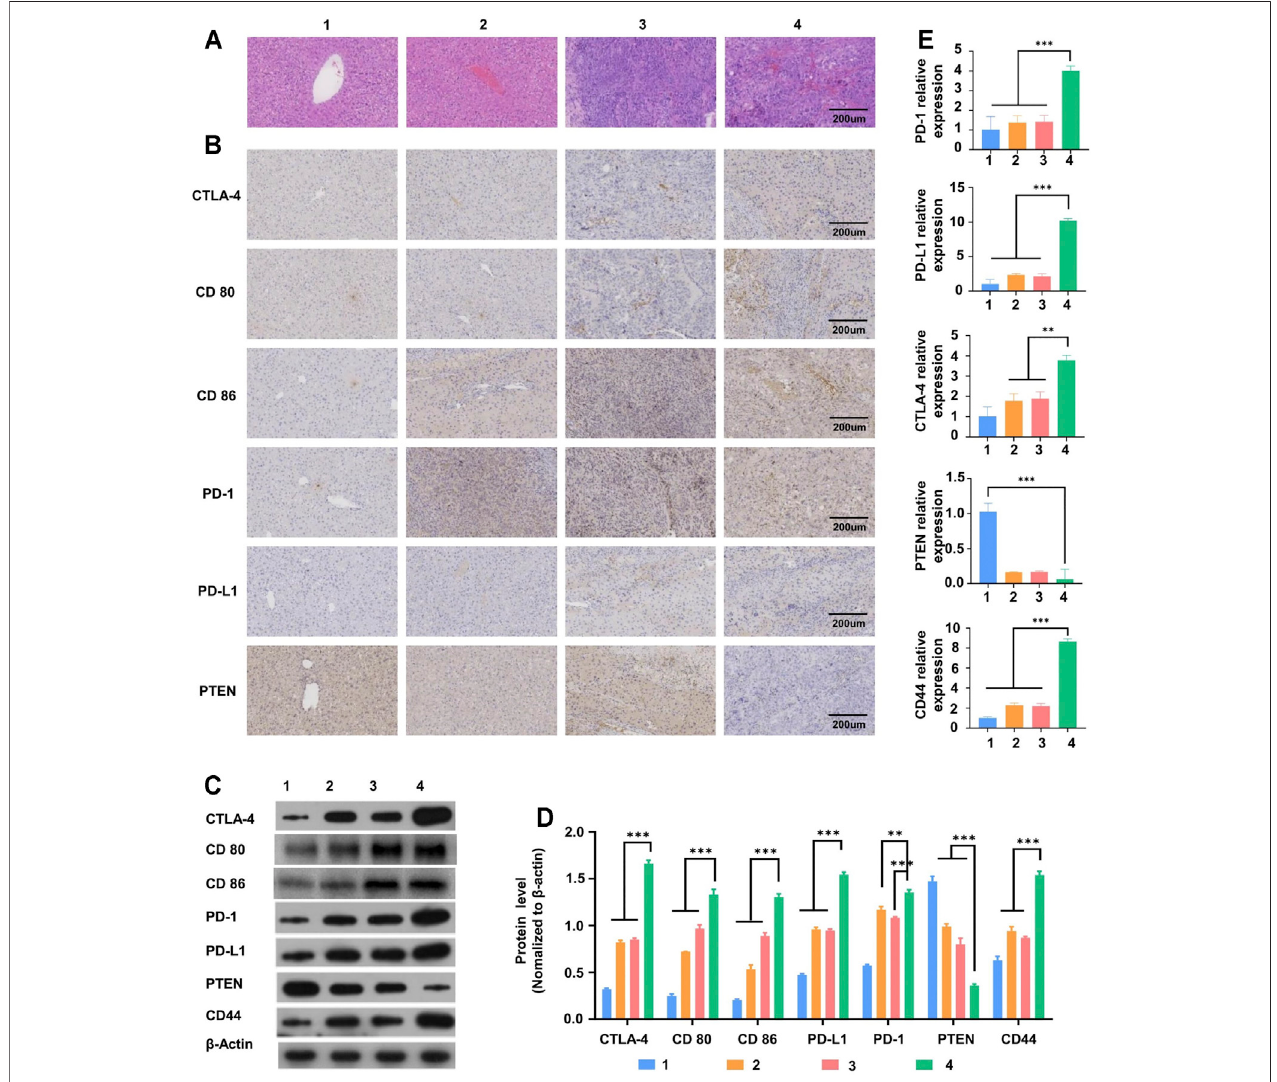
FIGURE 5 | Liver tissue slice morphology and molecular mechanism of liver tumor occurrence and development. (A) H&E staining observation of morphological changes of liver tissue sections of mice in different treatment groups, (B) immunohistochemical detection of CTLA-4 and other immune checkpoint protein